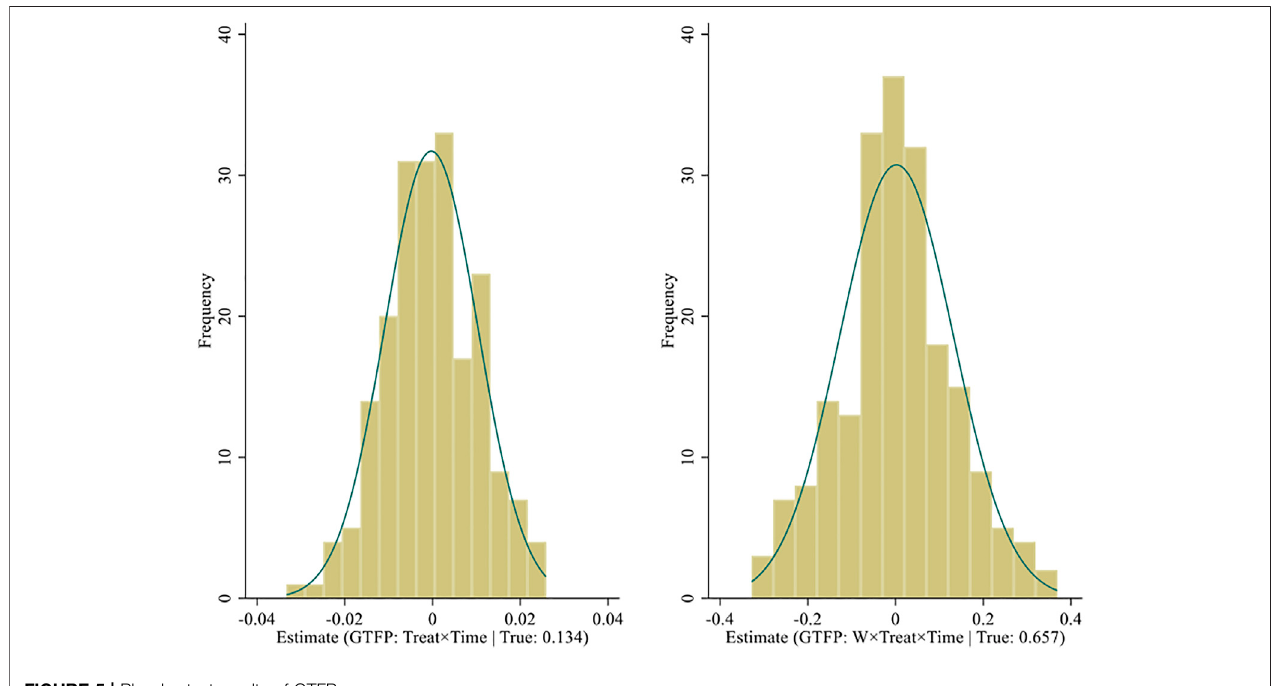
FIGURE 5 | Placebo test results of GTFP.